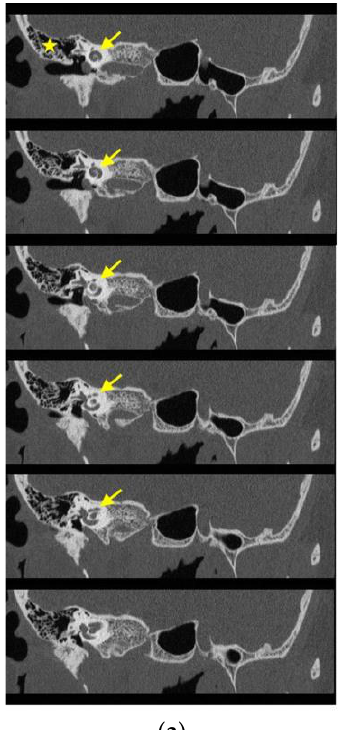
normal left carotid canal (white arrow on the patient’s left) and a hypoplastic carotid canal (white arrow on the patient’s right) were observed. The aforementioned findings from HRCT indicated a diagnosis of right aICA.